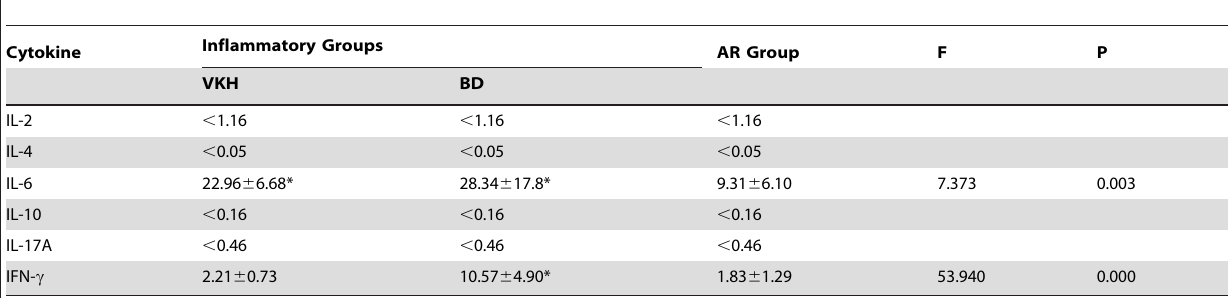
Table 2. Comparisons of the mean cytokine levels in the aqueous humor samples among the three groups via ANOVA.